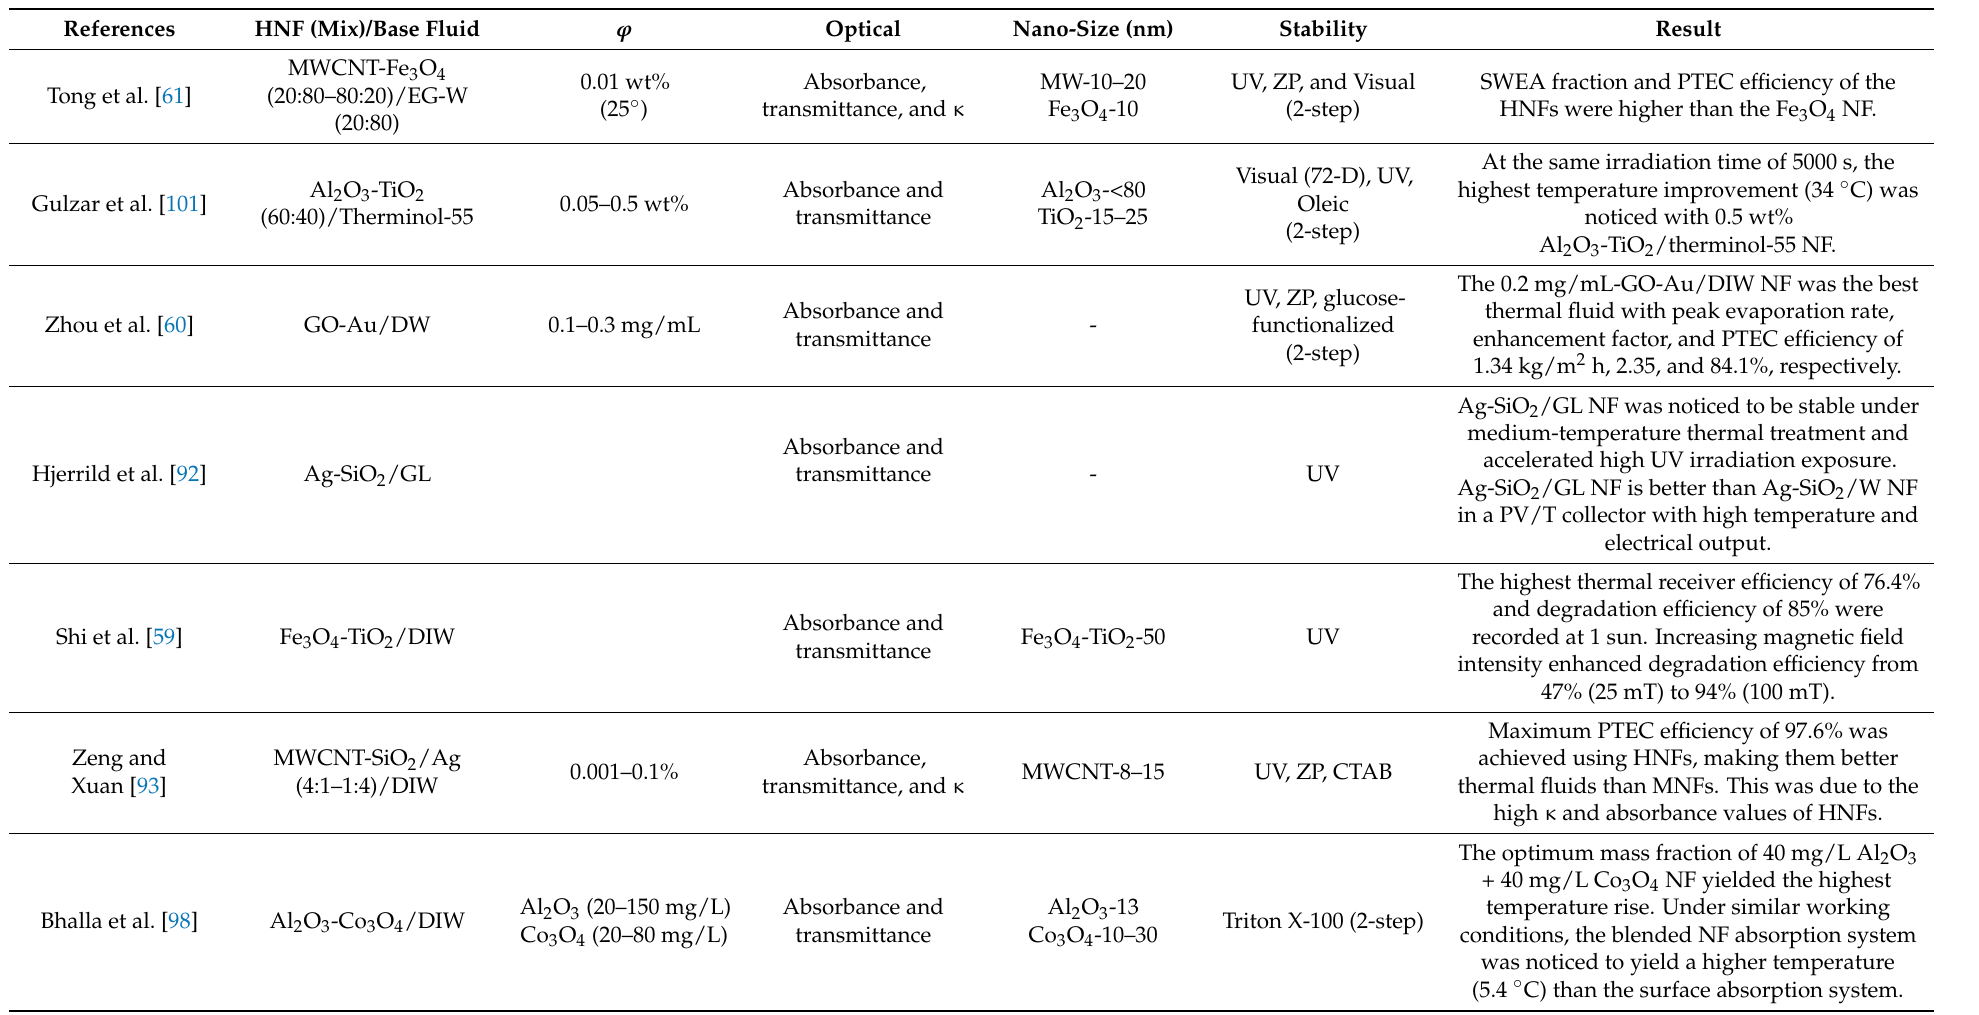
Table 2. Photothermal performance of HNFs with different HNPs, mixing ratios, optical properties, surfactants, process methods, and stability